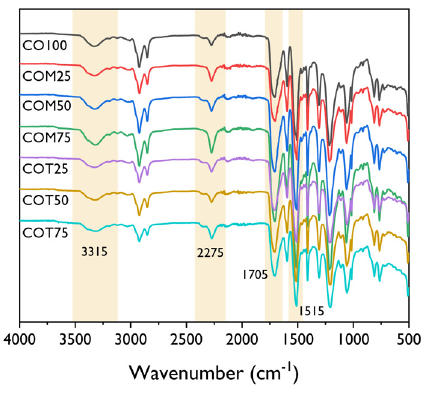
Figure 3. FT-IR spectra of the obtained PU foams.